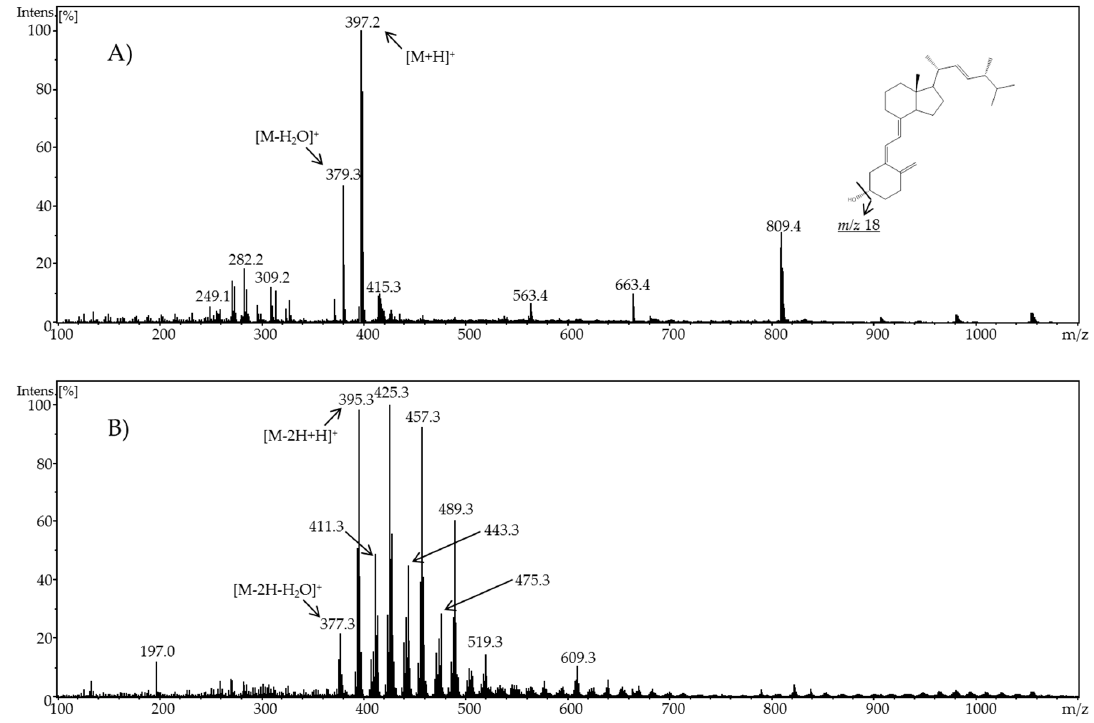
Figure 1. Full scan mass spectra of ( A ) pure ergocalciferol and ( B ) electrochemically-oxidized ergocalciferol using a potential of φ = 1.8 V at pH 7.4.